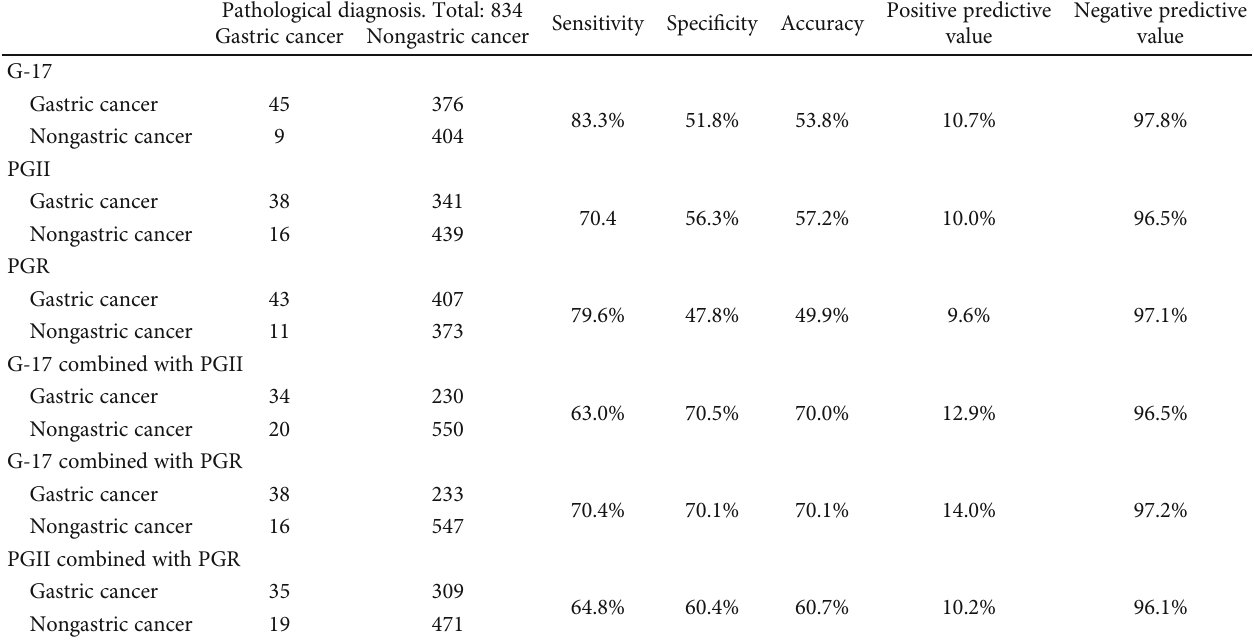
Table 3: Comparison between the diagnostic value of G-17, PGII, and PGR in gastric cancer and pathological. Pathological diagnosis. Total: